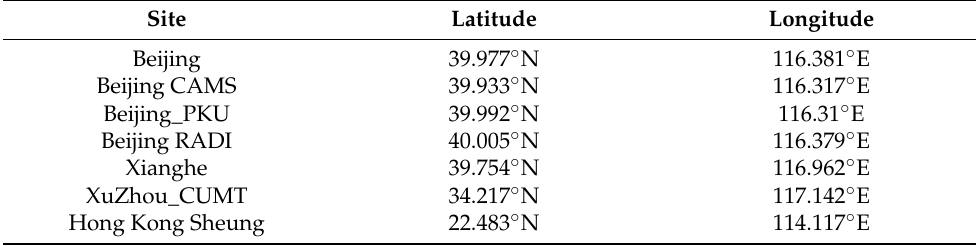
Table A1. Longitudes and latitudes of the AERONET sites used in this study.